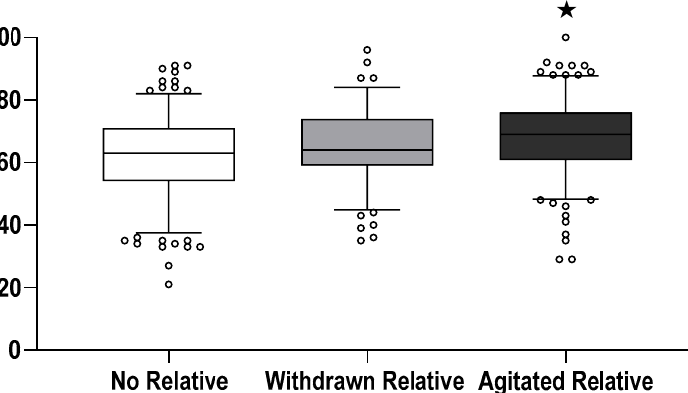
Data are medians [IQR]. Ratings are based on visual analogue scales ranging from 0 (minimum) to 100 (maximum). * = p < 0.05 vs. Control group; † = p < 0.05 vs. Withdrawn family member presence group.